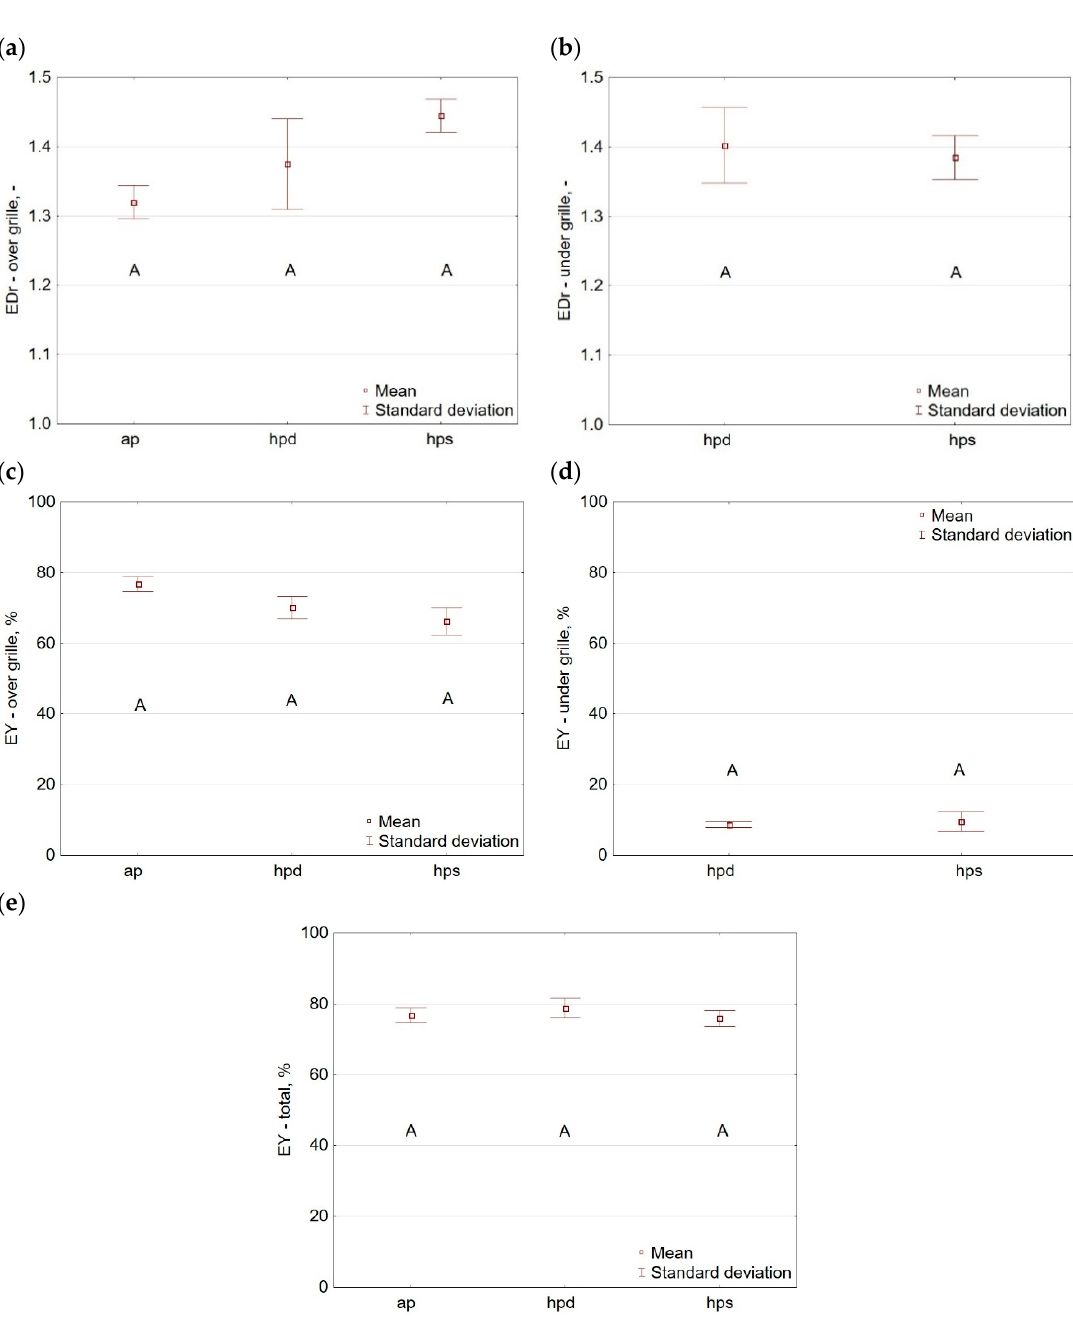
Figure 14. Energy densification ratio ( EDr ) and energy yield ( EY ) of the solid fraction, ( a ) EDr of over grille fraction, ( b ) EDr of under grille fraction, ( c ) EY of over grille fraction, ( d ) EY of under grille fraction, ( e ) EY of the total solid fraction.